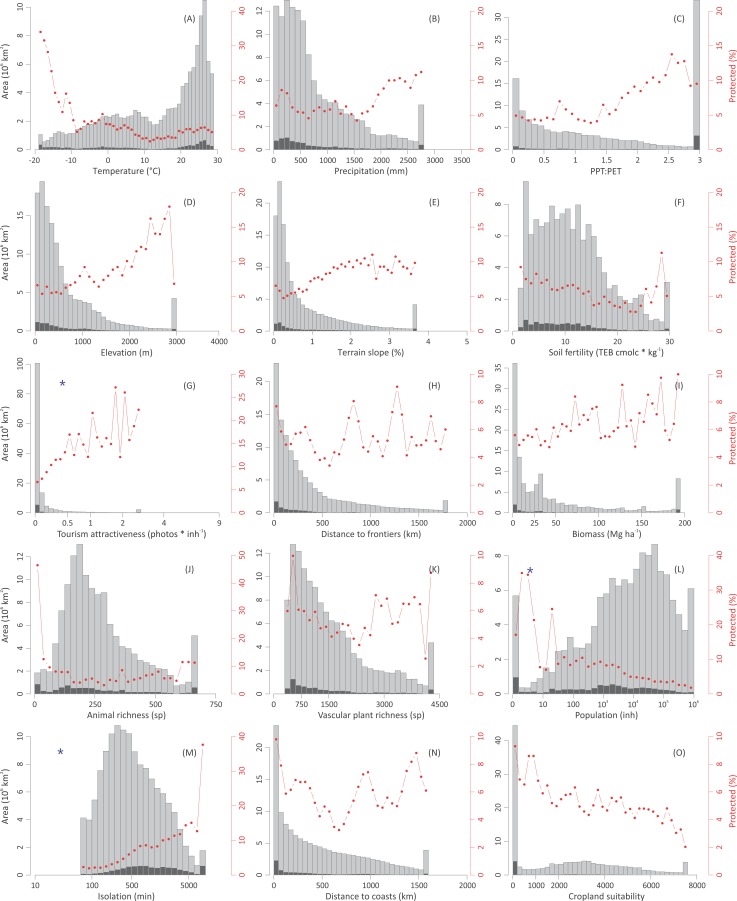
Global distribution of protected areas.Global distribution of protected areas along biophysical, human, and biological gradients. See graphic explanations in Fig. 2. Variables represented in (A–F) are related to the representativeness motivations, those in (G–K) are related to the preferential motivations, and those in (L–O) are related to the opportunistic forces. Lower and upper j classes were grouped using the percentile values 0.025 and 0.975 of the i independent variable. Blue asterisks denote that histograms were generated with the log10 transformed independent variable, and thus do not correspond to the untransformed data used for statistical analyses. Region-specific histograms are shown in Fig. S2.